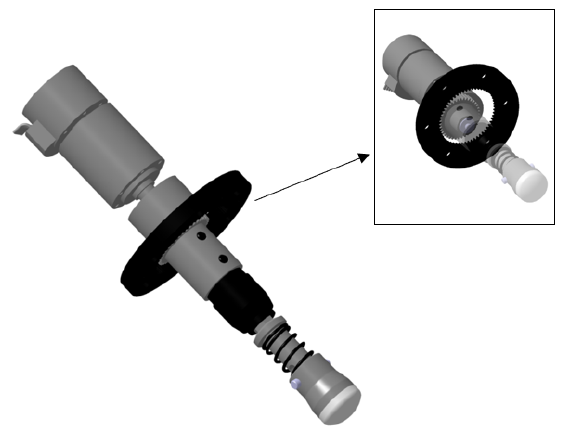
Figure 11. Internal components for the fixed-axis rotation design with a 15 mm diameter backing pad.